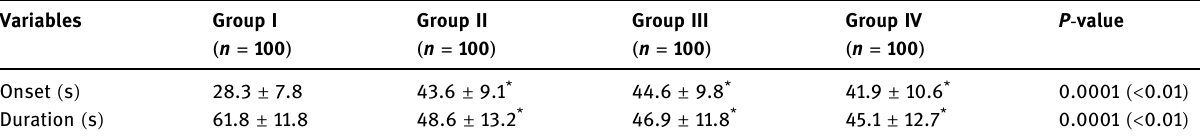
Table 4: The onset and duration of dexamethasone - induced perineal irritation